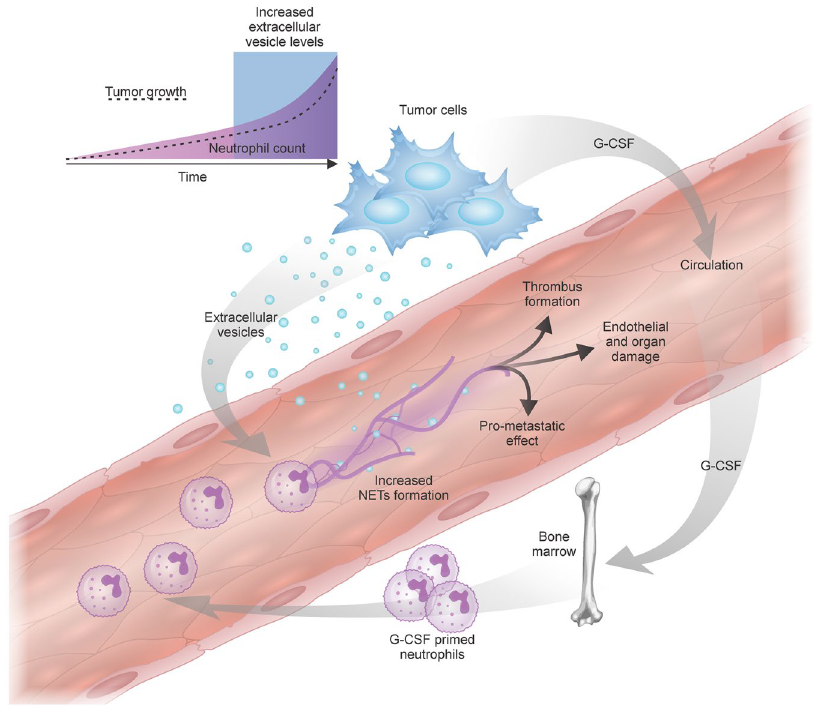
Figure 7. Schematic representation of the cooperation between tumor-derived EVs and neutrophils in tumor progression. The development of a thrombotic state in cancer patients is dependent on tumor-induced systemic alterations, including neutrophilia and increased levels of EVs (microvesicles and/or exosomes). Tumor-derived G-CSF acts in an endocrine fashion, stimulating the bone marrow to produce and export neutrophils to the bloodstream. The tumor also releases a large number of EVs into the circulation. The interaction between tumor-derived exosomes and G-CSF-primed neutrophils favors the release of NETs. Increased NET formation may favor tumor progression in various ways: 1) through the establishment of cancer-associated thrombosis; 2) by facilitating tumor cell arrest and encouraging metastasis; or 3) by promoting vascular damage and organ